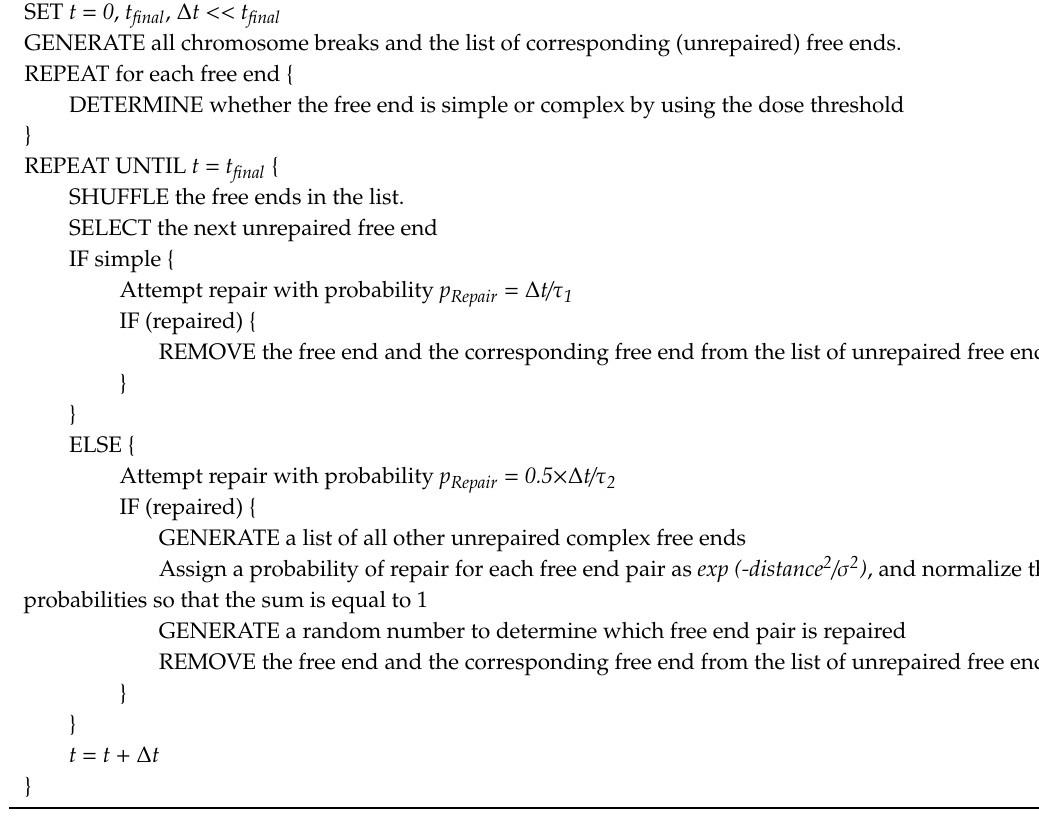
Algorithm 2 : Simulation of repair kinetics for breaks in RITCARD for one simulation history SET t = 0 , t final , ∆ t << t final GENERATE all chromosome breaks and the list of corresponding (unrepaired) free